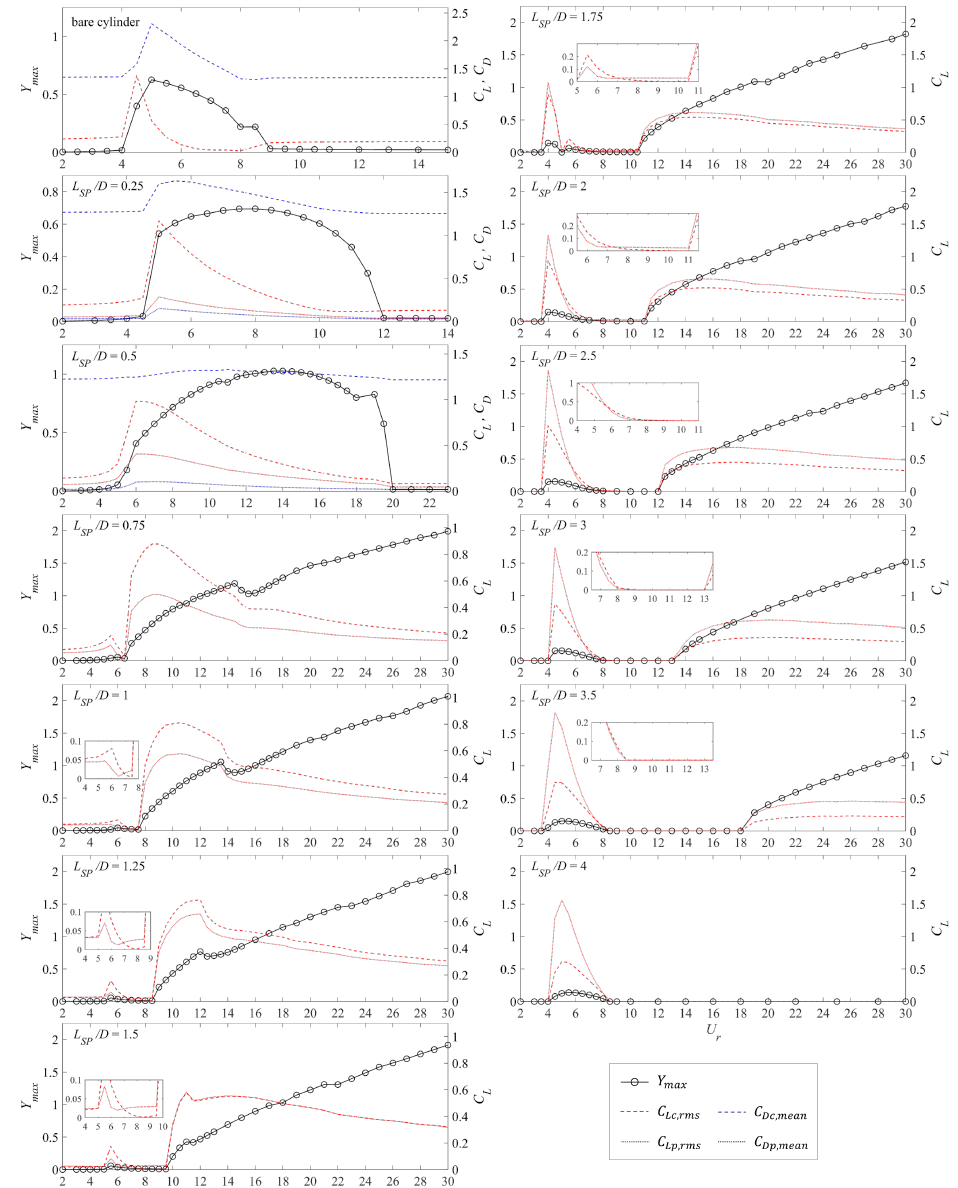
Figure 14. The maximum vibration amplitude Y max , the root-mean-square lift force coefficient and the mean drag force coefficient acting on the cylinder ( C Lc , rms , C Dc , mean ) and the plate ( C Lp , rms , C Dp , mean ) as a function of the reduced velocity U r for six representative values of the splitter-plate